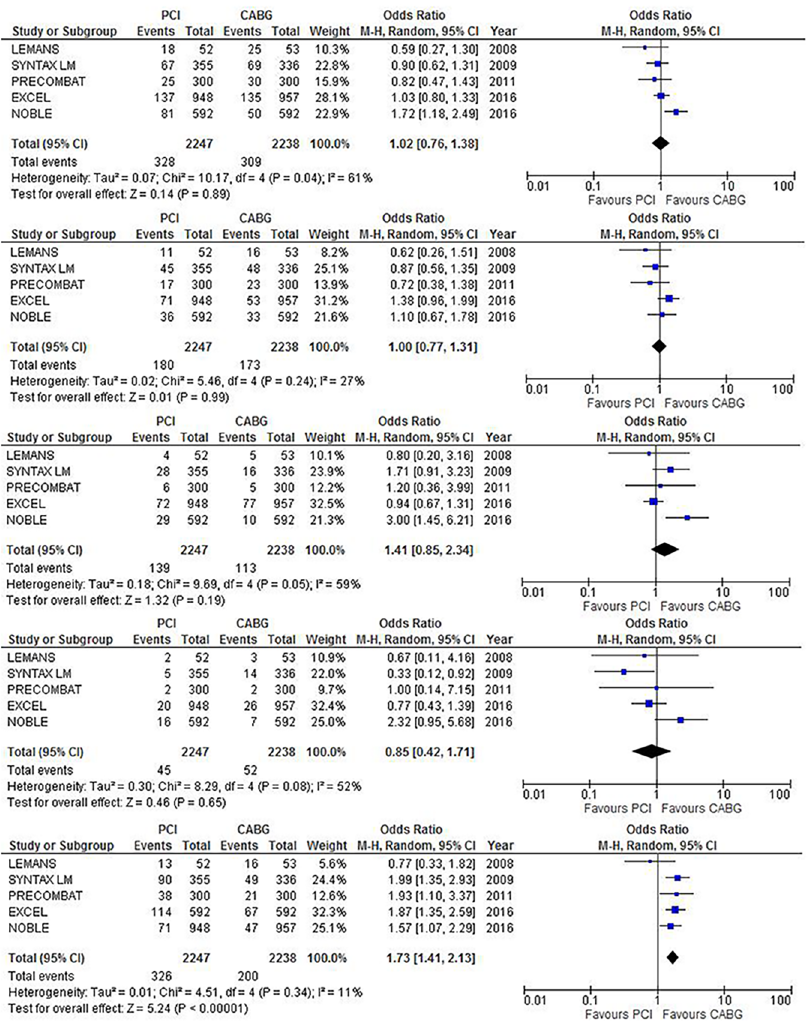
Fig 3. Major adverse cardiovascularevents at a median FU of 5 years, mean 5.6 years(from top to bottom, MACE, Death, MI, Stroke, TVR).